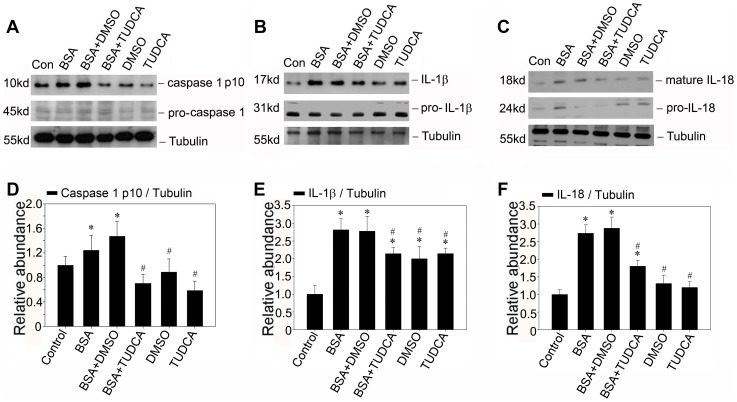
TUDCA attenuates the inflammasome activation induced by BSA in NRK-52E cells in vitro.A, B and C: Western blot analysis shows TUDCA attenuates the caspase-1 activation and maturation of IL-1β and IL-18 protein induced by BSA in NRK-52E cells. Growth arrested NRK-52E cells were pretreated without (same amount of DMSO) or with 100 umol/L TUDCA for 0.5 hours, and then followed by incubation without or with 5 mg/ml BSA for 12 hours as indicated. C, D and E: Graphic presentation showed the relative abundance of caspase-1, IL-1β and IL-18 protein after normalization with α-tubulin in various groups. Data are presented as mean±SEM of three independent experiments. *P<0.05 vs. normal control; # P<0.05 vs. group with BSA treatment.